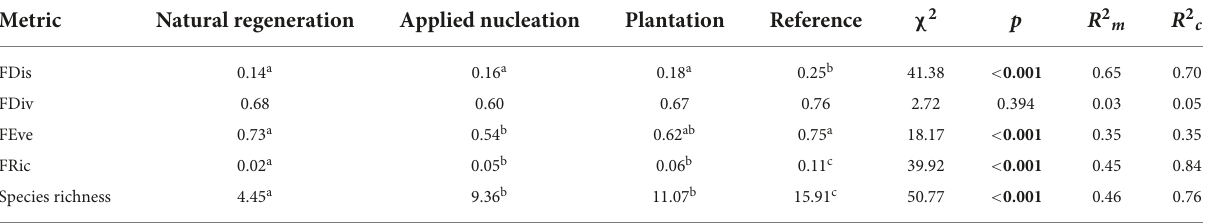
TABLE 2 Estimated marginal means (EMMs) for tree sapling functional richness (FRic), divergence (FDiv), dispersion (FDis), and evenness (FEve), and mean species richness values in each treatment in 2019, estimated with linear mixed models. Metric Natural regeneration Applied nucleation